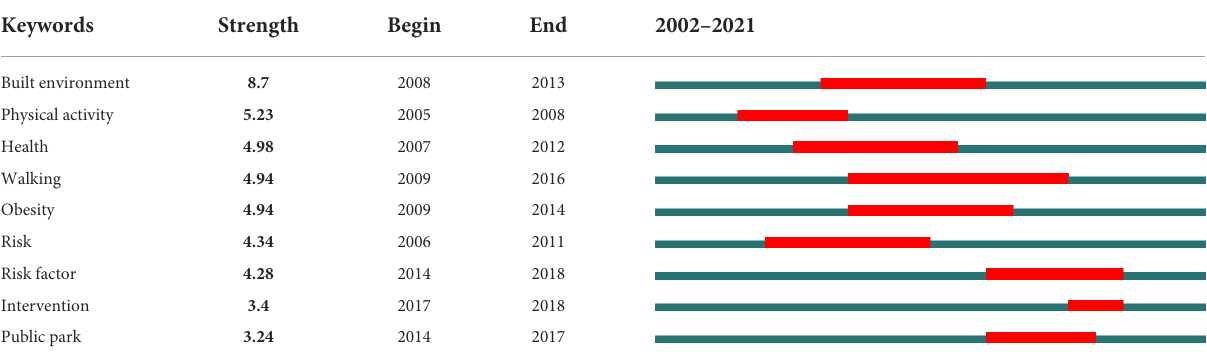
TABLE 6 Top 9 keywords with the strongest citation bursts from 2002 to 2021.